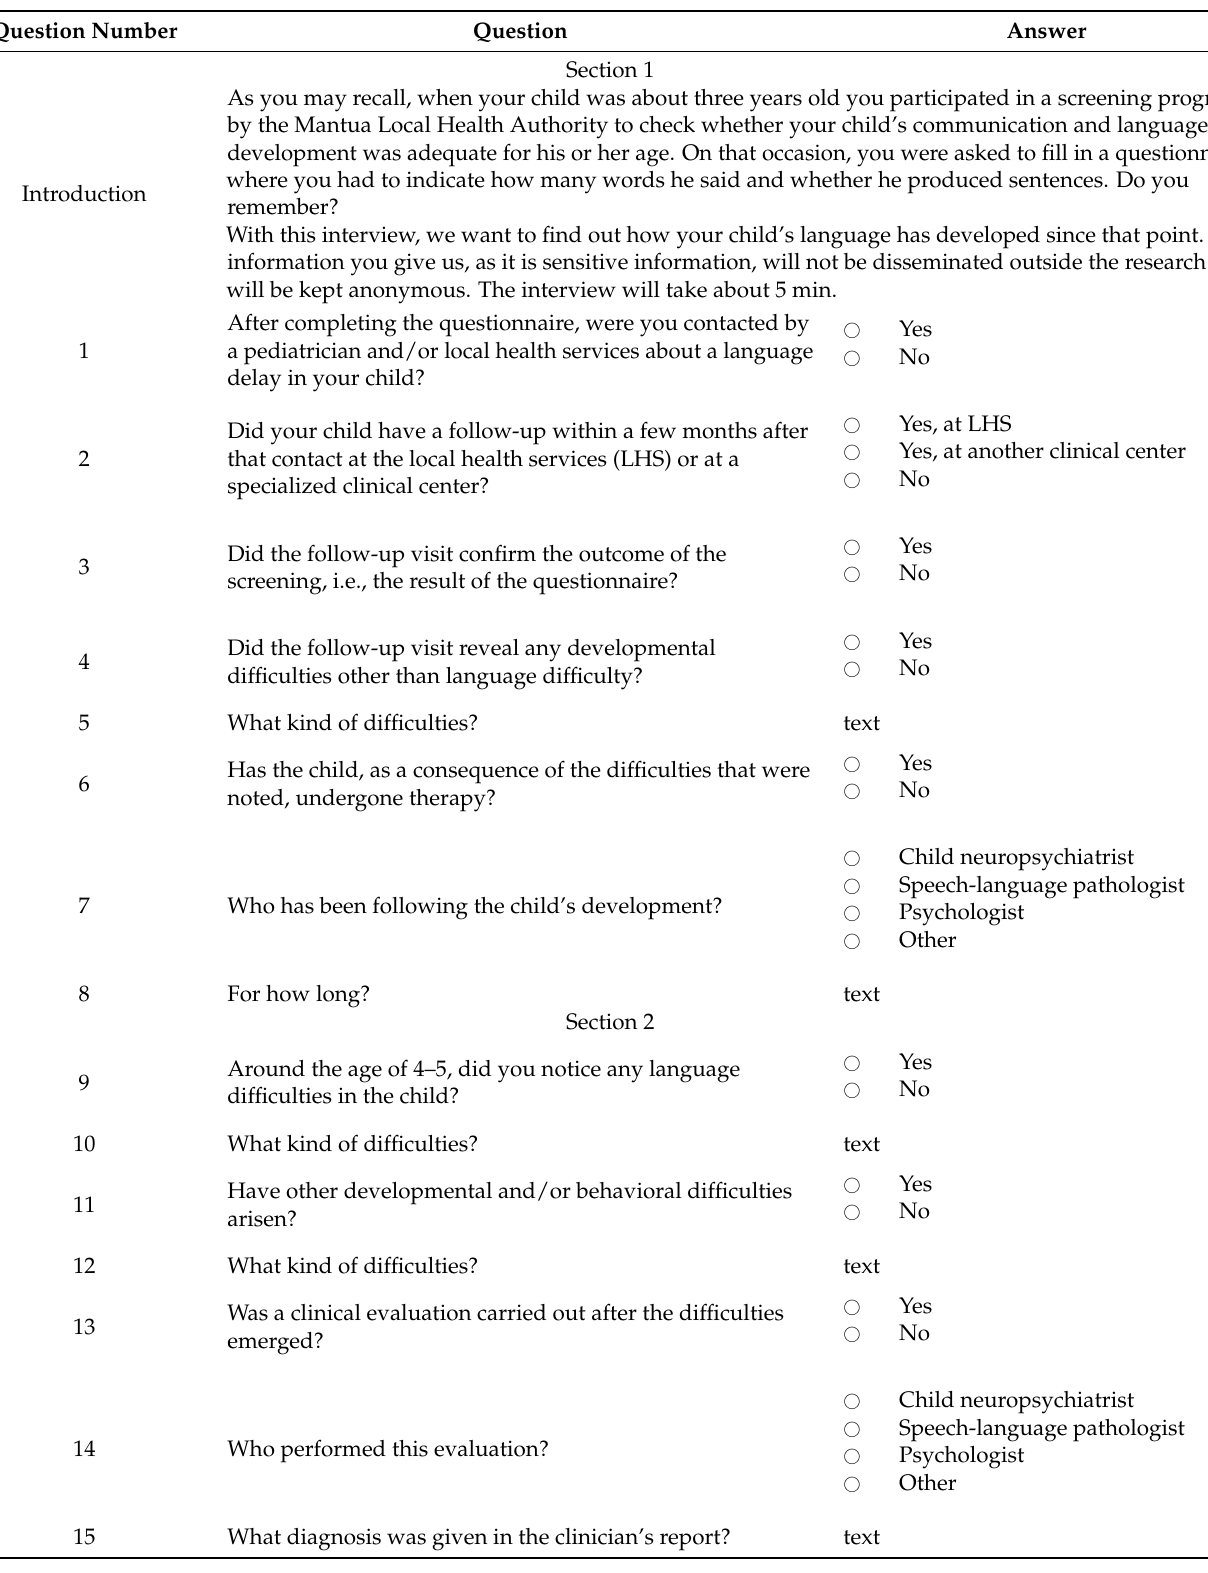
Table A1. English translation of the parental